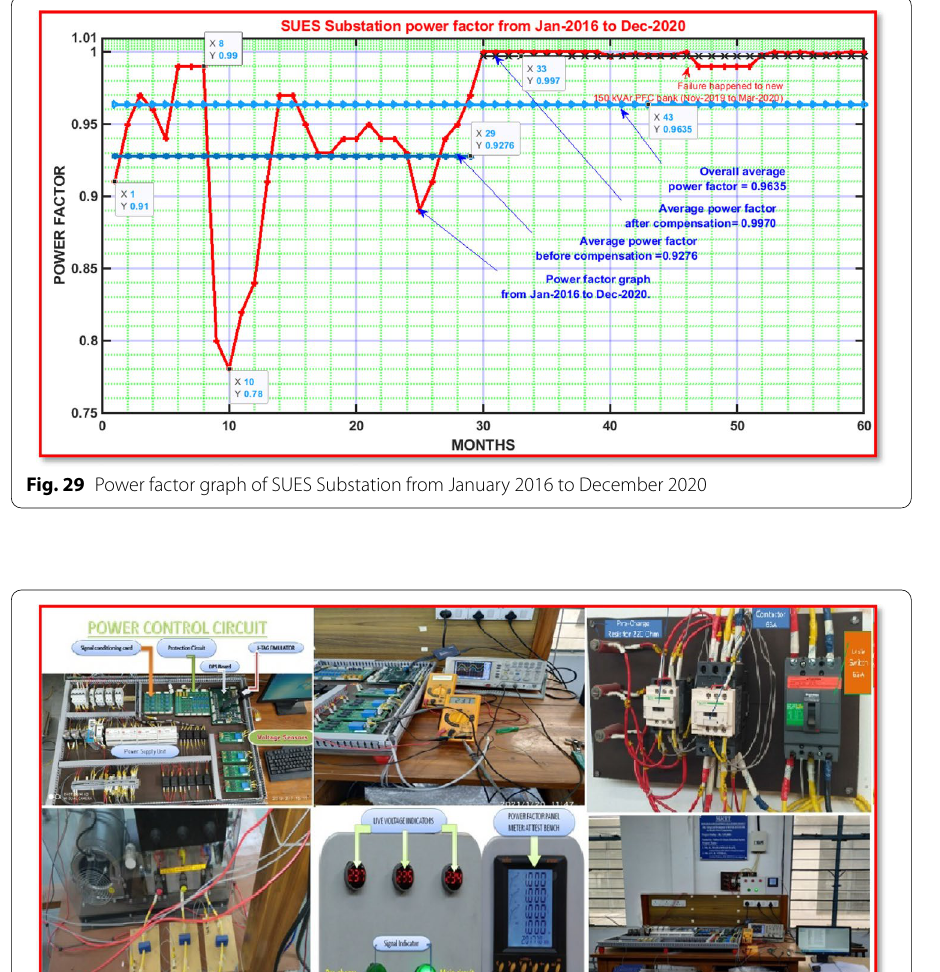
kVAr PFC panel. The combined total cost and expenditure of these three units are Rs. 11,48,200/-, and the details are shown in Appendix A. If the system is not installed, the average power factor of the substation is 0.9276. The fictitious kVAh is calculated based on the average power factor (0.9276) in the substation before installation of power factor correction equipment. The SUES would have paid Rs. 1,14,40,762/- extra to TSSPDCL for the active energy consumption of 14,31,615 units. The average Substation power fac- tor is shown in Fig. 29. After the system is installed in June 2018, the power factor has increased near to unity. In this case, the SUES has paid Rs. 1,05,91,462/- to electricity board. The total amount saved because of installation of the system during the period from June 2018 to December 2020 is Rs. 8,49,300/-. The detailed calculations are given in Appendix-A Table 4. The average monthly amount saved with this project is calcu- lated from June 2018 to December 2020 is Rs. 27,397/-. The payback period can easily be